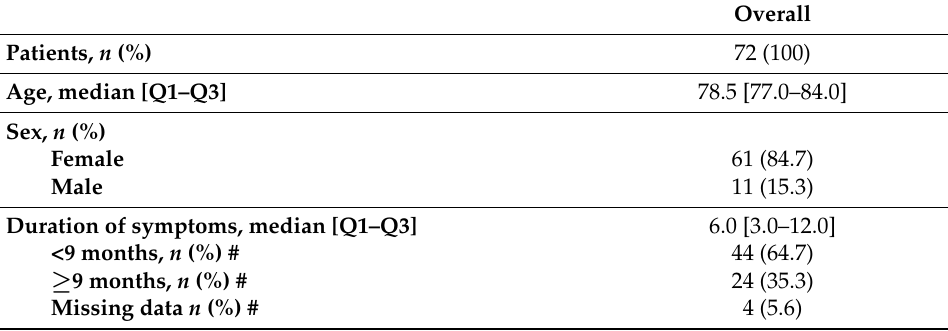
Table 2. The cohort’s characteristics ( n =